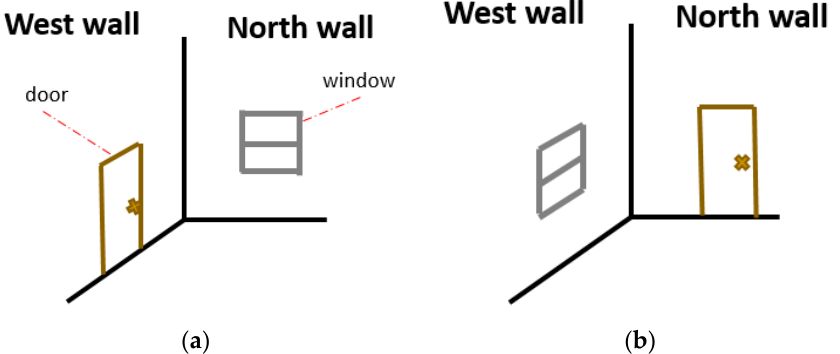
Figure 4. An example of two scenes in one room during renovation. ( a ) West wall captured (before renovation); ( b ) North wall captured (after renovation).